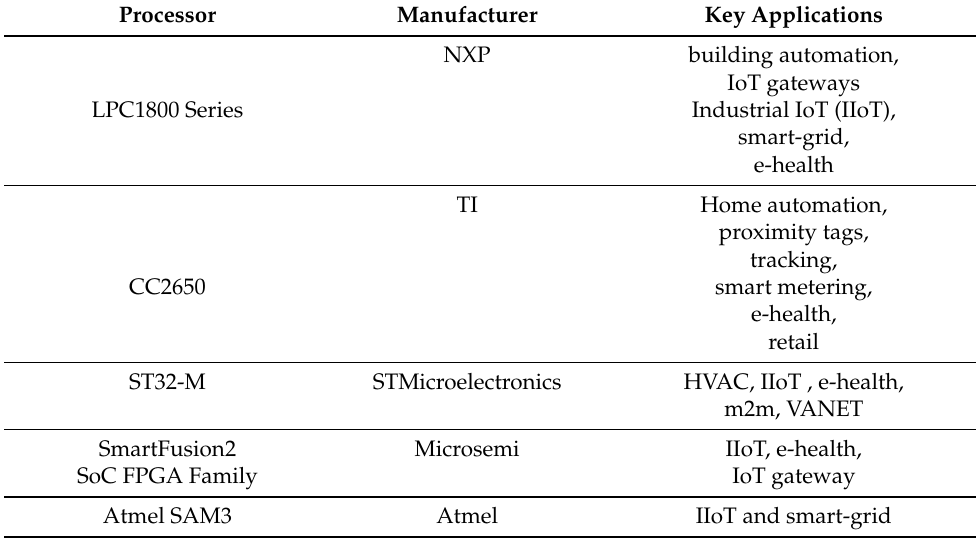
Table 4. Market survey of the cortex-M3 processor in the IoT domain.